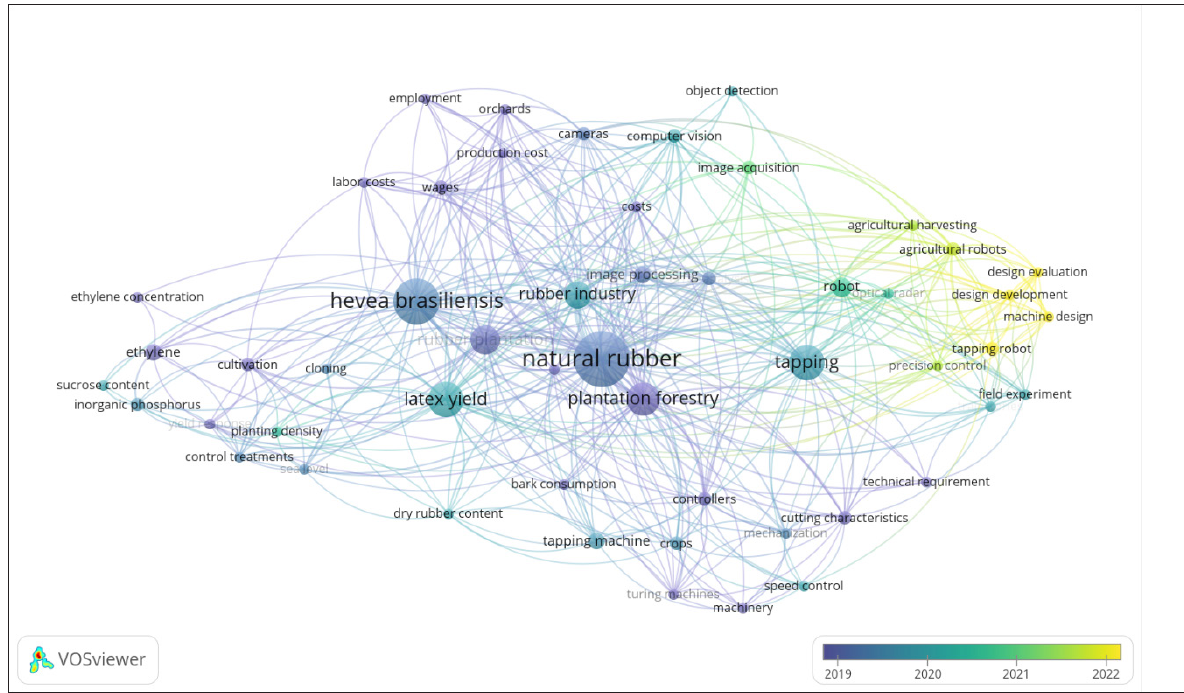
Figure 3. Overlay map of keywords related to latex harvesting practices using two minimum occu - rrences threshold from 38 papers included in the analysis. The bigger circle indicates a higher fre- quency of appearance of the keyword. Lines show networks among